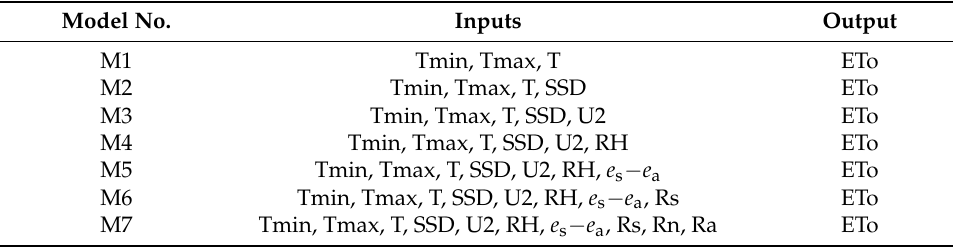
Table 4. Inputs applied for developing the classical ANFIS and the two hybrid models (ANFIS-SFLA and ANFIS-IWO). Symbols are explained in Section 2.1 and in the footnote of Table 2. Model No.